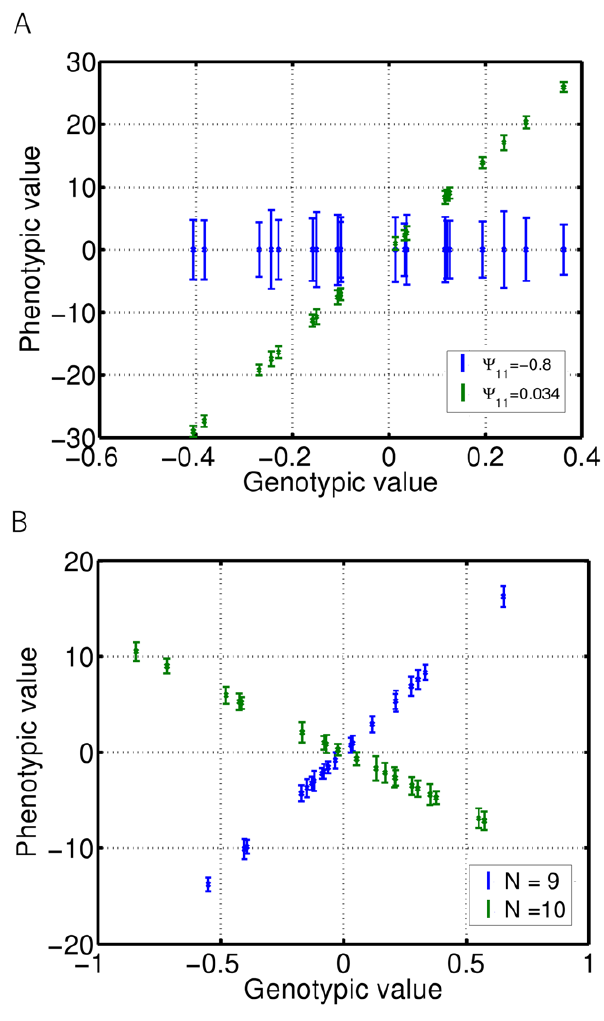
Figure 6. Inter and intragroup phenotypic variance. Mean phenotypic value and variance of each group are calculated and plotted against mean genotypic value of the group. Errorbars represent intragroup variance. Simulation of a scenario when a given trait in a focal individual affects the same trait in other individuals, as shown in Figure 1 (A). Simulation of 20 groups of 30 individuals. Blue - interaction strength Y 11 ~{ 0 : 8 , green - interaction strength Y 11 ~ 0 : 034 . (B) Simulation of 20 groups of 9 (blue) or 10 (green) individuals; interaction strength Y 11 ~ 0 : 105 .